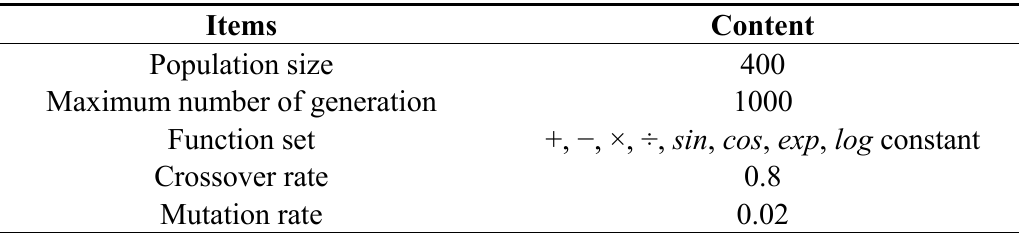
Table 1. The settings of GP model.